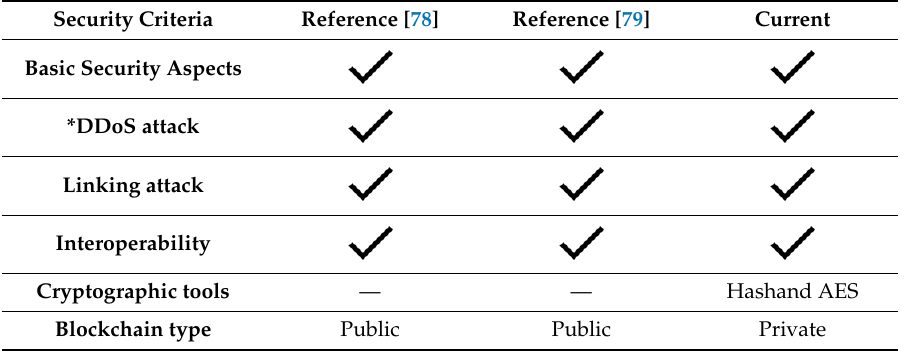
Table 2. Comparison of investigations with the contribution in this paper.